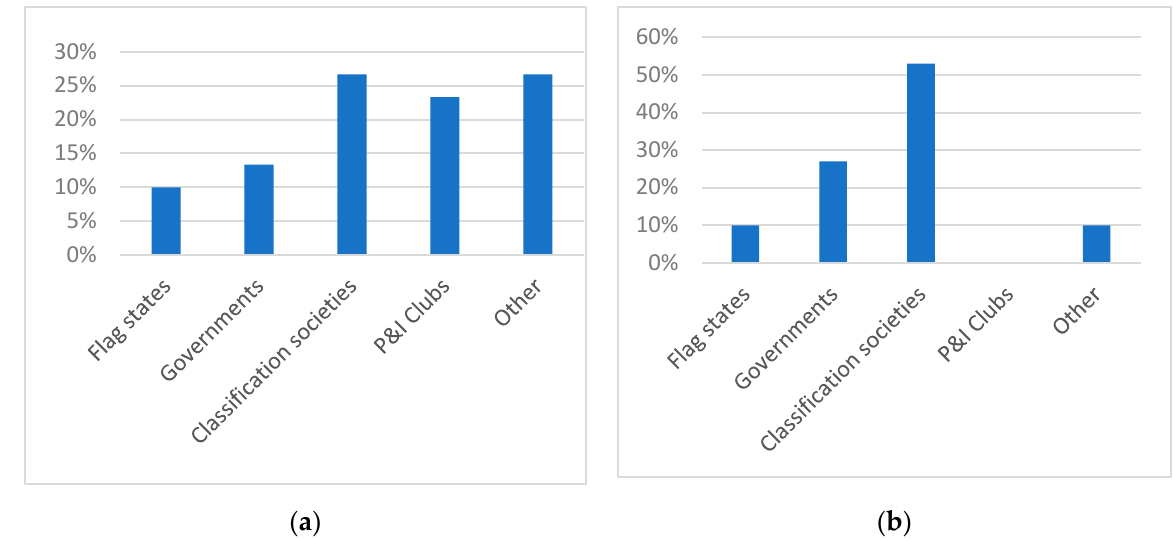
Figure 3. Which agency is more suitable to assist and guide the maritime transport sector in addressing cyber security? ( a ) Europe; ( b ) Asia.